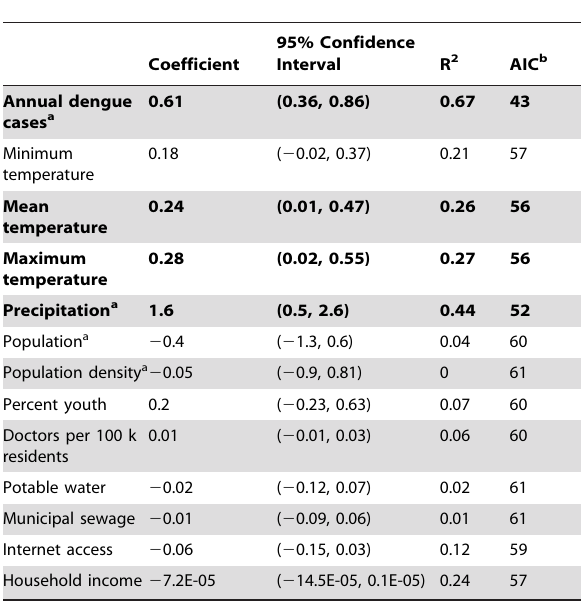
Table 1. Determinants of logit-transformed R 2 between Google Dengue Trends and government reported dengue cases: single covariate